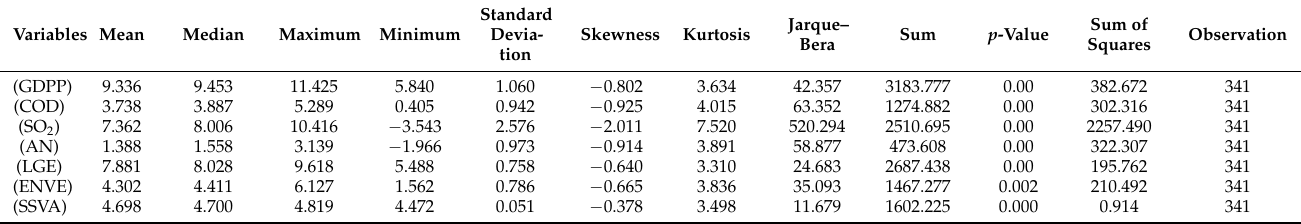
Table 2. Descriptive statistics of the study variables.